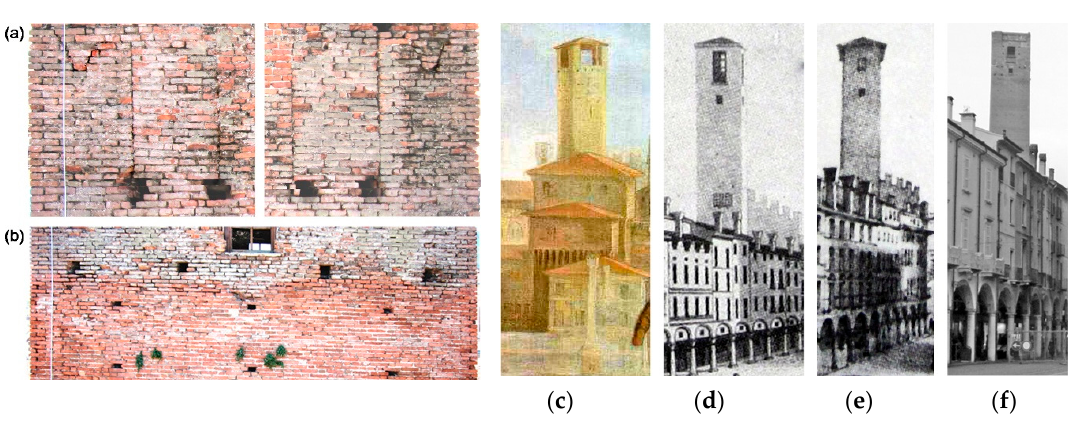
Figure 2. Structural discontinuities detected in the upper part of the Gabbia Tower in Mantua: ( a ) probable merlons embedded in the masonry texture; ( b ) change in the surface workmanship at about 8.0 m from the top; views dated back to ( c ) XVII century; ( d ) 1830; ( e ) 1852 and ( f ) present day. [7].